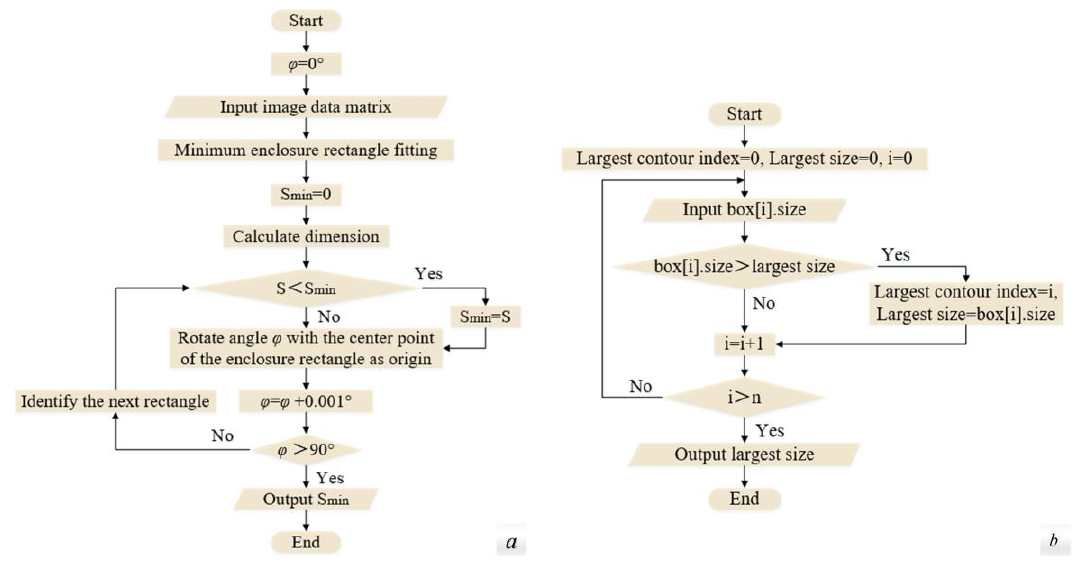
Figure 7. Flowchart of dimensional measurement. ( a ) The minimum enclosure rectangle fitting. ( b ) The algorithm of maximum size search.